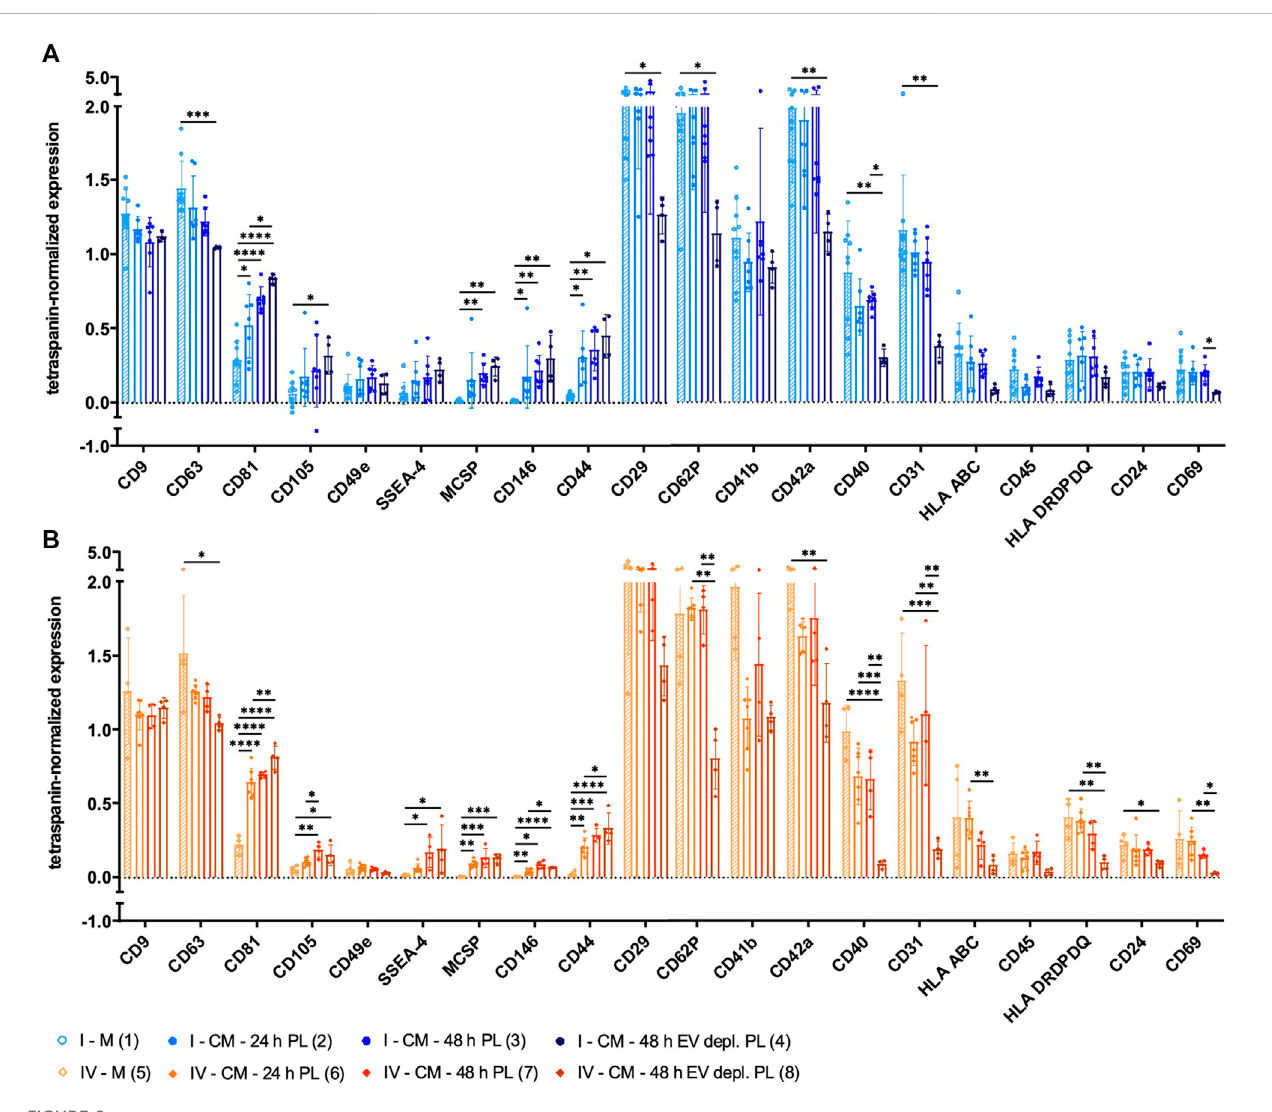
Tetraspanin-normalized surface antigen expression by sEVs collected with different strategies. sEVs were isolated from the media α MEM+8% PL (M) (1 and 5; with stripes) and MSC CM, where sEVs were collected for 24 h (2 and 6) and 48 h (3 and 7) for α MEM+8% PL cultures and for 48 h for α MEM+8% EV depl. PL cultures (4 and 8). Methods I (blue scheme) (A) and IV (orange scheme) (B) were used for sEV isolation from M and CM. The expression of several surface antigens by sEVs was analyzed using MACSPlex technology. sEVs were bound by capture beads with epitopes against each analyzed surface antigen and detected indirectly by an APC-coupled detection reagent directed against the tetraspanins CD9, CD63, and CD81. Due to the indirect detection, fl uorescence intensity of each surface antigen was normalized on mean fl uorescence intensity of CD9, CD63, and CD81, resulting in tetraspanin-normalized expression.Dataarepresentedasmean±SD,andN ≥ 4independentexperimentswereperformed.Statisticallysigni fi cantdifferencesaredepictedasfollows: *: p < 0.05, **: p < 0.01, ***: p < 0.001, ****: p <